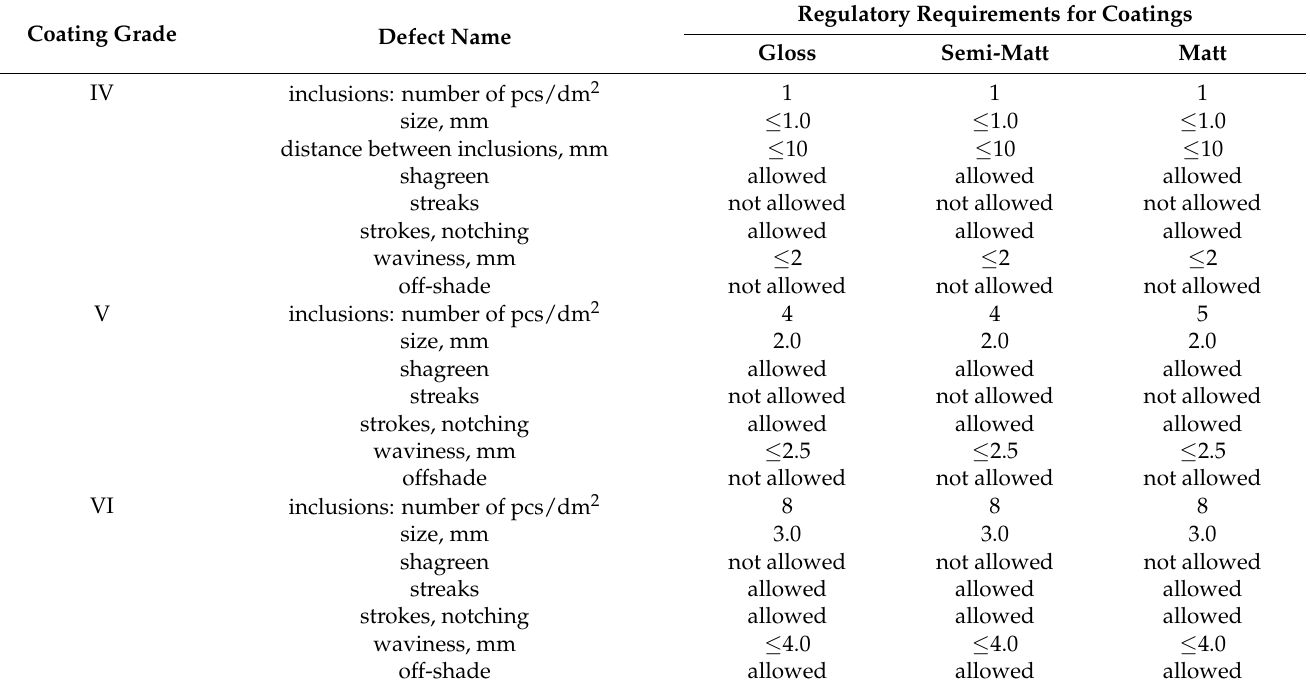
Table 1. Permissible defects for coatings depending on their